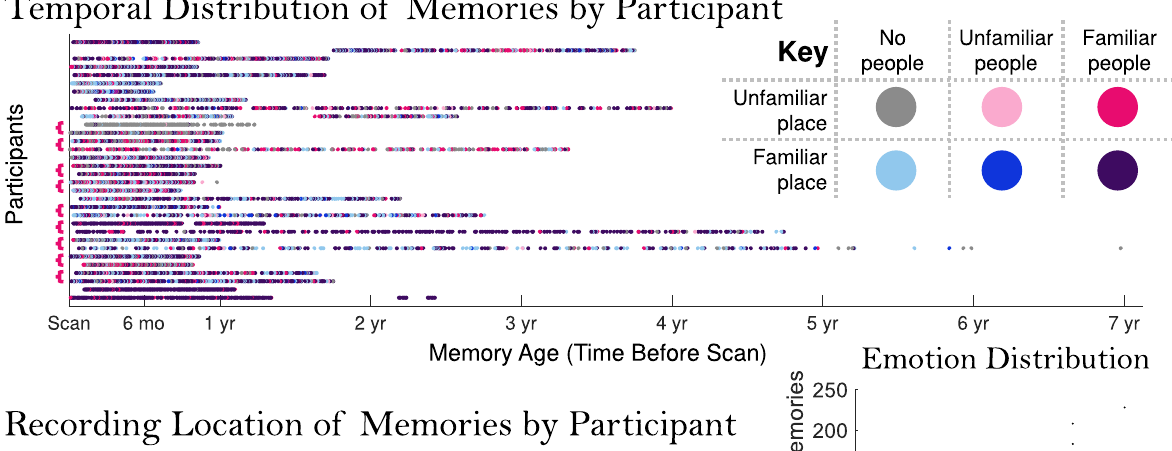
in familiar places, others recording a majority of videos with novel people, places, or both, and even others recording a mix of all content types. The spatial dis- tribution shows the locations of all videos, with each dot representing a video and each color representing a participant. Videos were in diverse locations, with many across the world, even more across the United States, and a large number con- centratedintheWashingtonDCarea(wherethestudywasconducted).Lookingata distribution ofthe emotional ratings for the memories, the documented videos, in general, tended to be neutral or positive (rather than negative). Memory strength ratings were evenly distributed from very weak to very strong. Error bars indicate thestandarderrorofthemeanacrossparticipants.Sourcedataareprovidedinthe Source Data fi